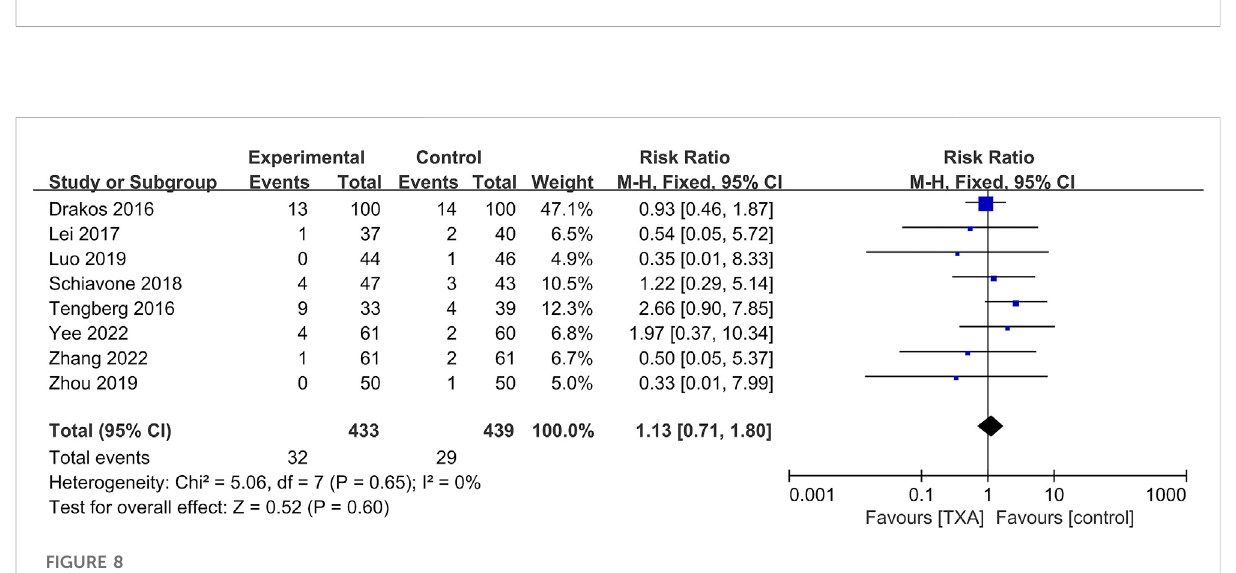
FIGURE 7 Forest plot showing the incidence of other complications of TXA group vs. control group. (A) Wound complications. (B) Respiratory infection. (C) Renal failure.